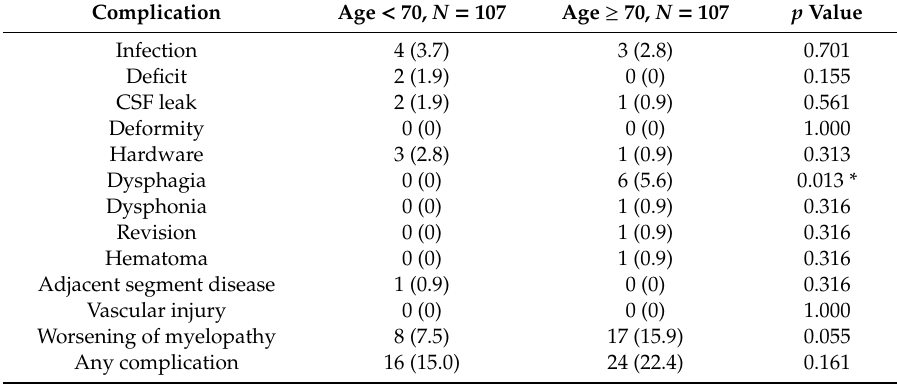
Table 4. List of complications of elderly and younger adult cohorts over the two-year follow up.